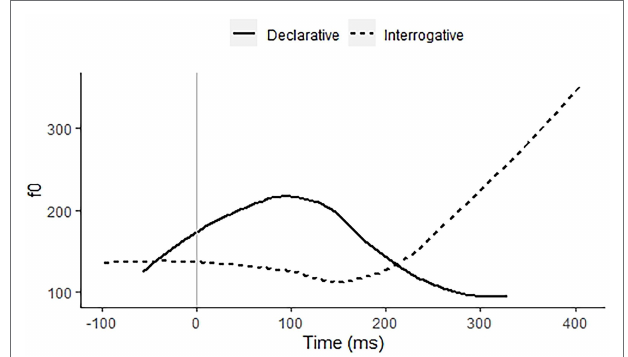
FIGURE 1 | f0 contours of declarative (solid line) and interrogative (dashed line) citation pronunciations of the monosyllabic word gong (“gong”), recorded by a 28-year-old male speaker of Standard